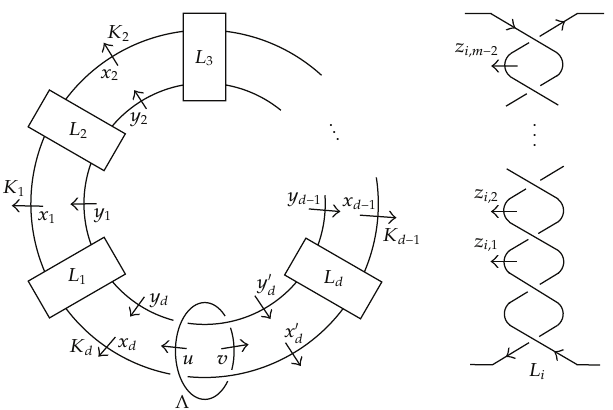
Figure 2: L (cid:3) m,d (cid:4) with surgery coe ffi cients and L i with (cid:3) 1 /m (cid:4) -rational